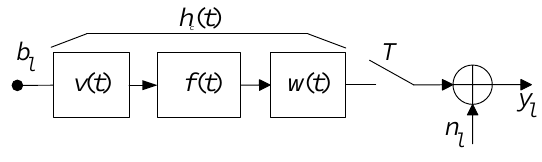
Figure 1. Baseband model of a digital communication